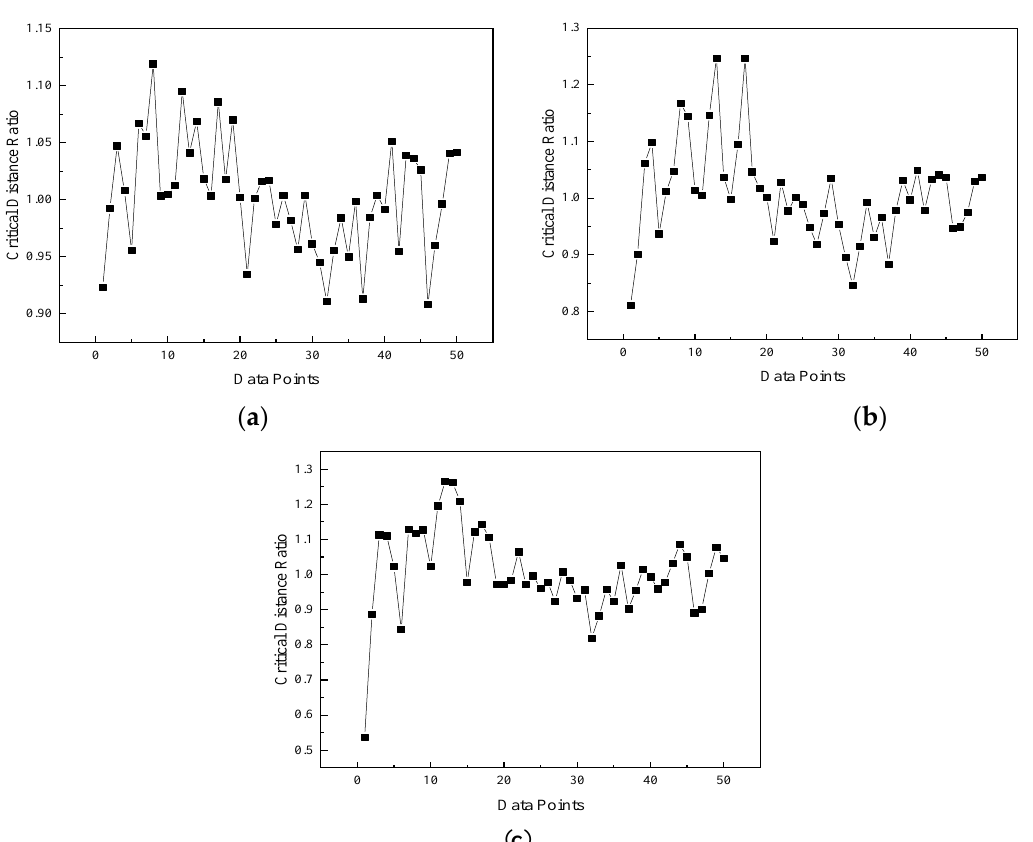
Figure 10. Critical distance ratio K of the three models: ( a ) the exterior wall; ( b ) the interior wall; ( c ) the interior and exterior wall.